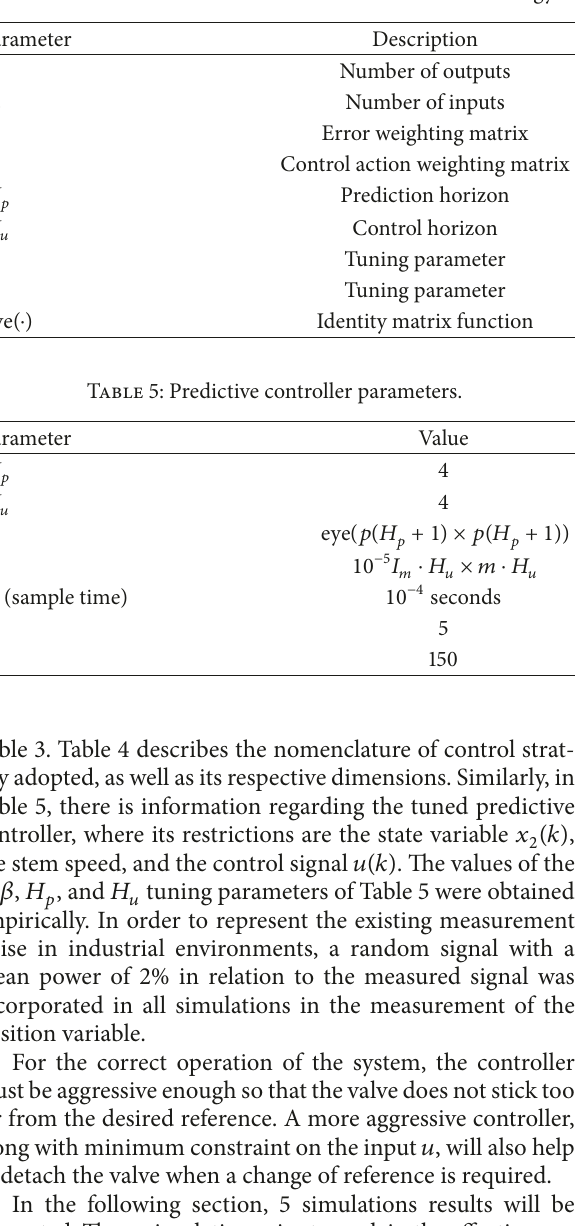
Table 3: Parameters estimated valve control (adapted from [2]). Table 4: Nomenclatures in mathematics of the control strategy.